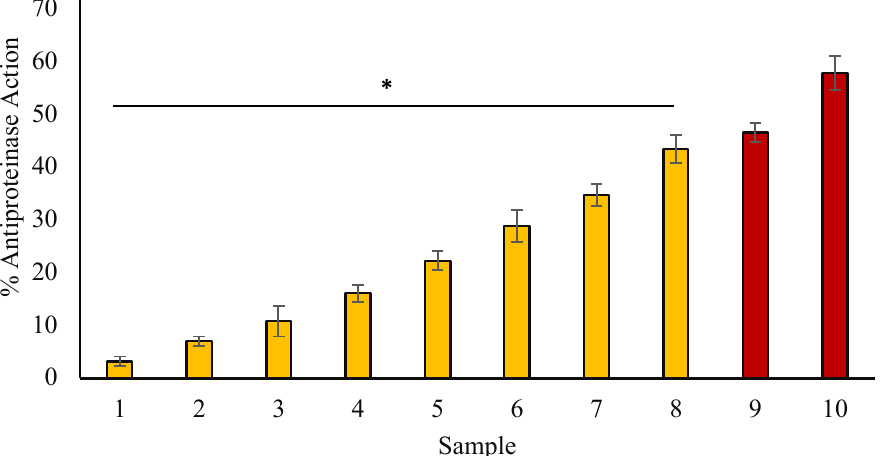
Figure 4. The percentage inhibition of proteinase action. Yellow columns (1–8) represent samples with various concentrations (50, 75, 100, 200, 300, 400, 500, and 600 µg/mL) of myrrh extract. The red columns (9 and 10) represent samples having 100 and 200 µg/mL concentrations of diclofenac, respectively. The data are shown as means ± standard error of the means (n = 3, p < 0.05). The statistical differences are represented with an asterisk (*) for myrrh denoting significance at p < 0.05 in comparison with the reference sample.